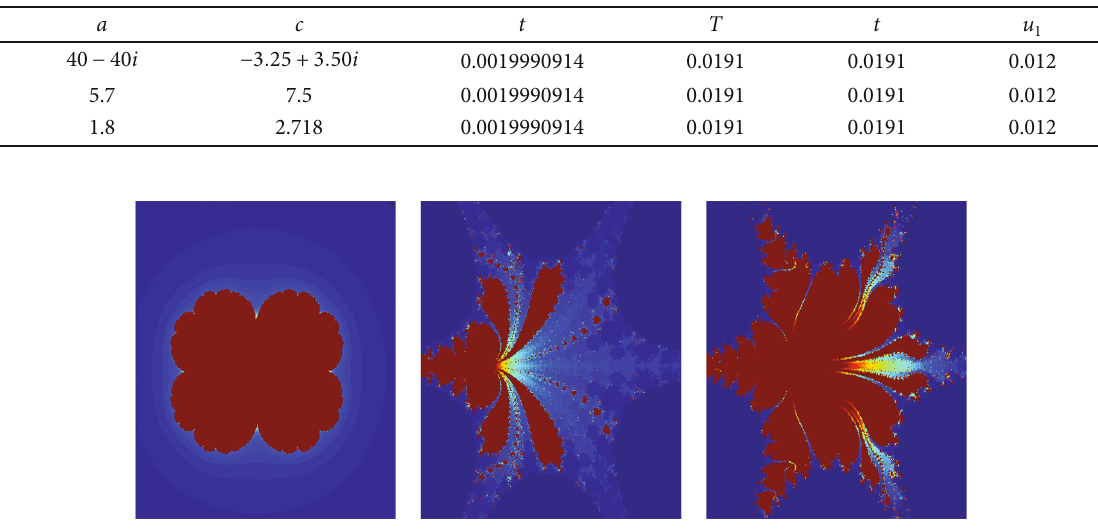
Figure 4: E ff ect of increase in the absolute value of a on quadratic Julia set. Table 4: Parameters for generation of cubic Julia set for di ff erent values of a and c .